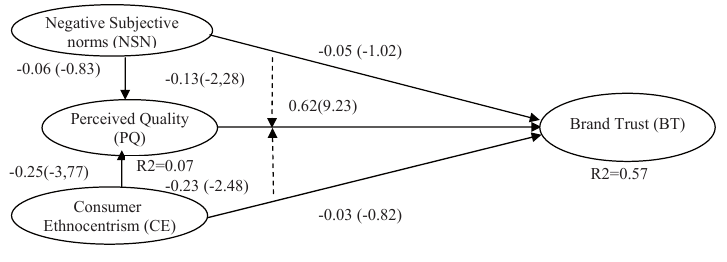
Fig. 3 - Extended Model. Source: own.